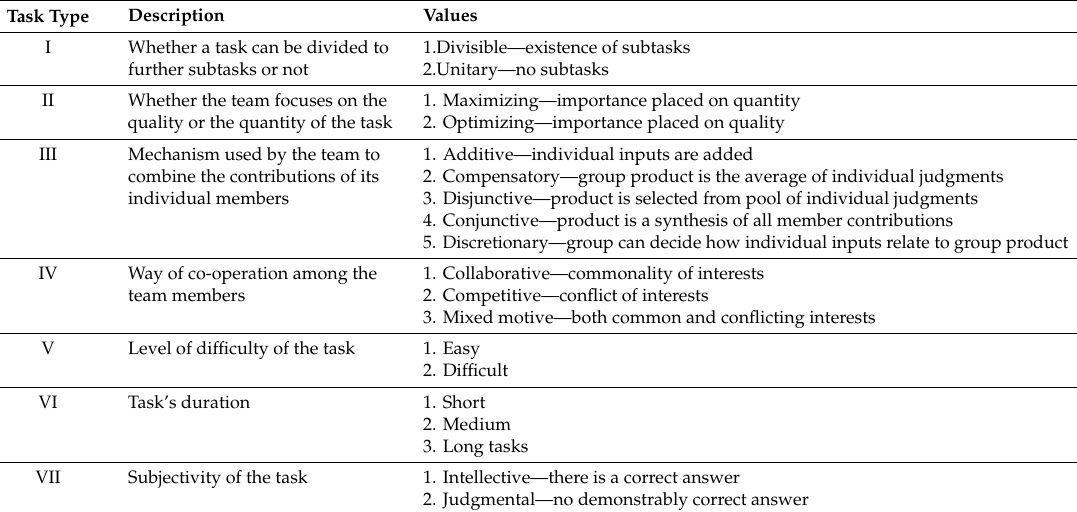
Table 1. Current task in the task